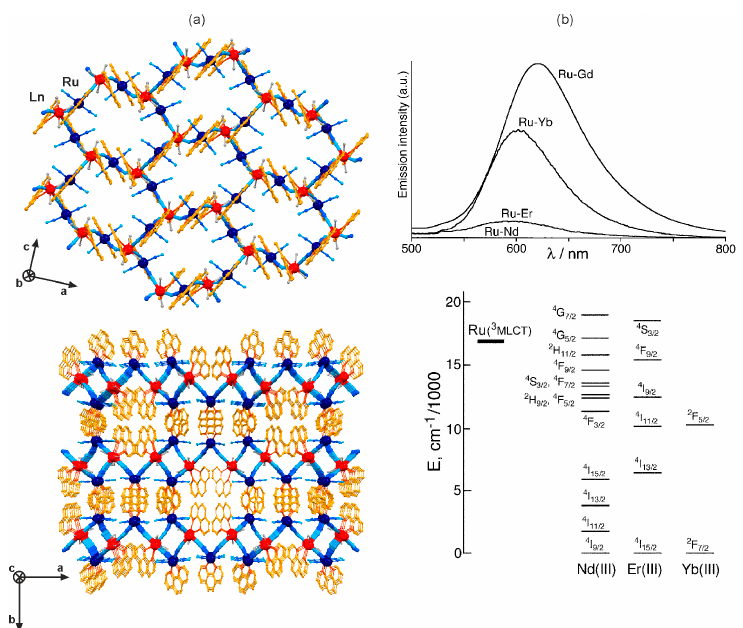
Figure 9. Crystal structure and optical properties of two-dimensional [Ln III (phen)(H 2 O) 3 ] 2 [Ru II (phen)(CN) 4 ]·14H 2 O (Ln = Nd, Gd, Er, Yb; phen = 1,10-phenanthroline) coordination polymers: ( a ) the views of the cyanido-bridged layer, and the arrangement of layers, ( b ) the lanthanide- dependent room temperature emission spectra in the visible range together with the related energy level diagram. Colours for the structural diagram: Ln, red; Ru, dark blue; CN − , blue; phen, orange; H 2 O, grey. Adapted from Ref. [114] with permission from The Royal Society of Chemistry.